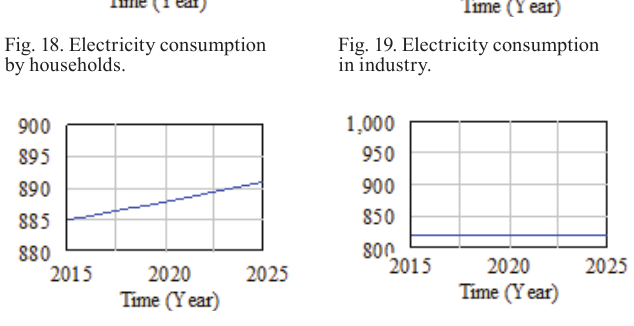
Fig. 21. Electricity consumption in rail